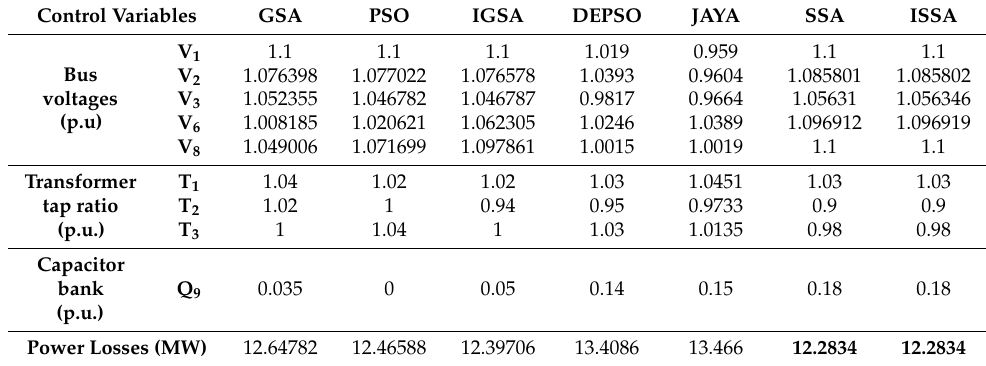
Table 4. Optimal control variables settings for power-loss minimization for IEEE 14-bus system.